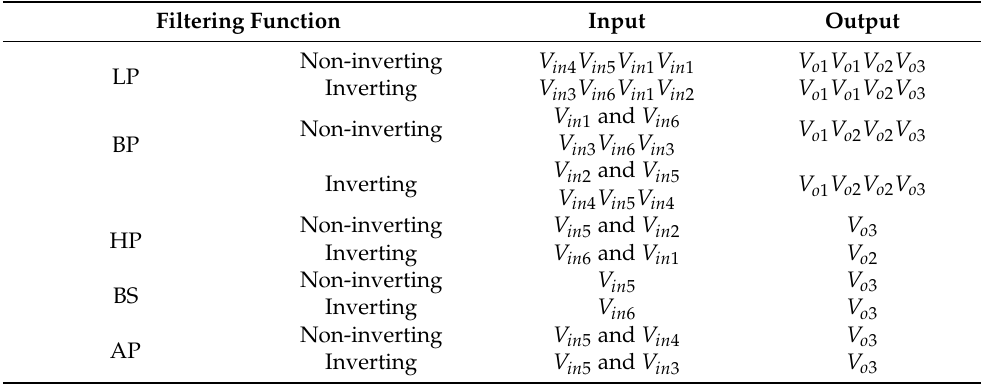
Figure 5. Proposed universal filter using standard G m [26] ( a ), and MI-G m ( b ).